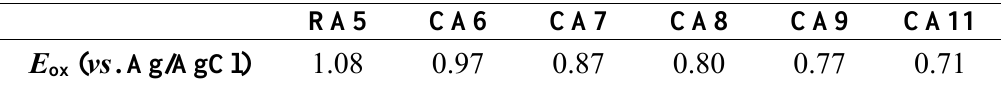
Table 2. One-electron oxidation potentials in dichloromethane (in V) (reprinted with permission from [11] © 2005, American Chemical Society).